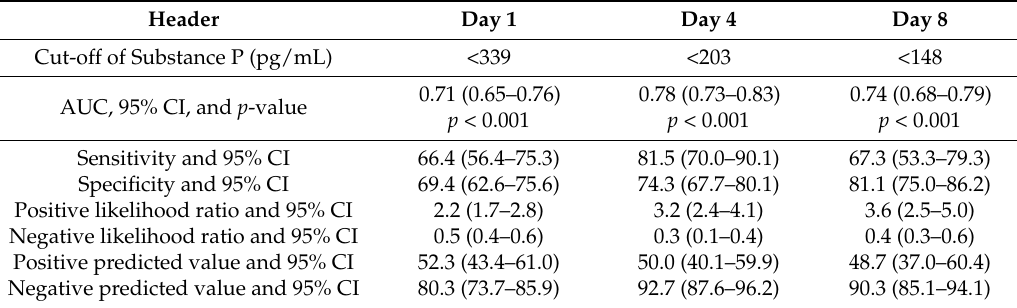
Table 4. Receiver operation characteristic analysis using serum Substance P levels at days 1, 4, and 8 as predictor of mortality at 30 days in severe septic patients: sensitivity, specificity, positive and negative likelihood ratios, positive and negative predicted values.